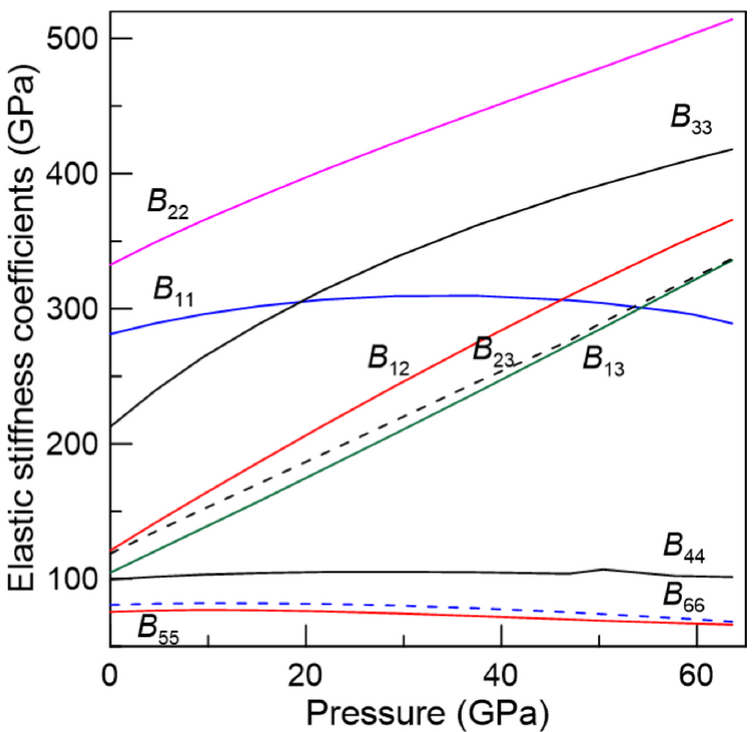
Figure 6. Calculated pressure evolution of the elastic stiffness coefficients B ij of DyScO 3